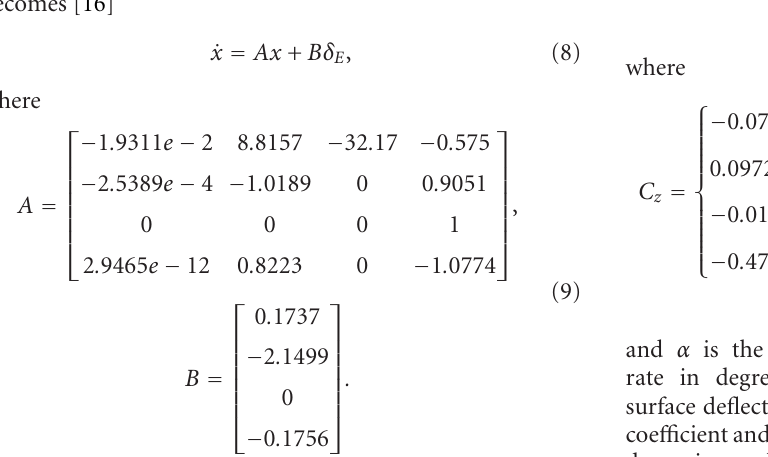
Figure 4: NN versus state-space models for F-16 longitudinal